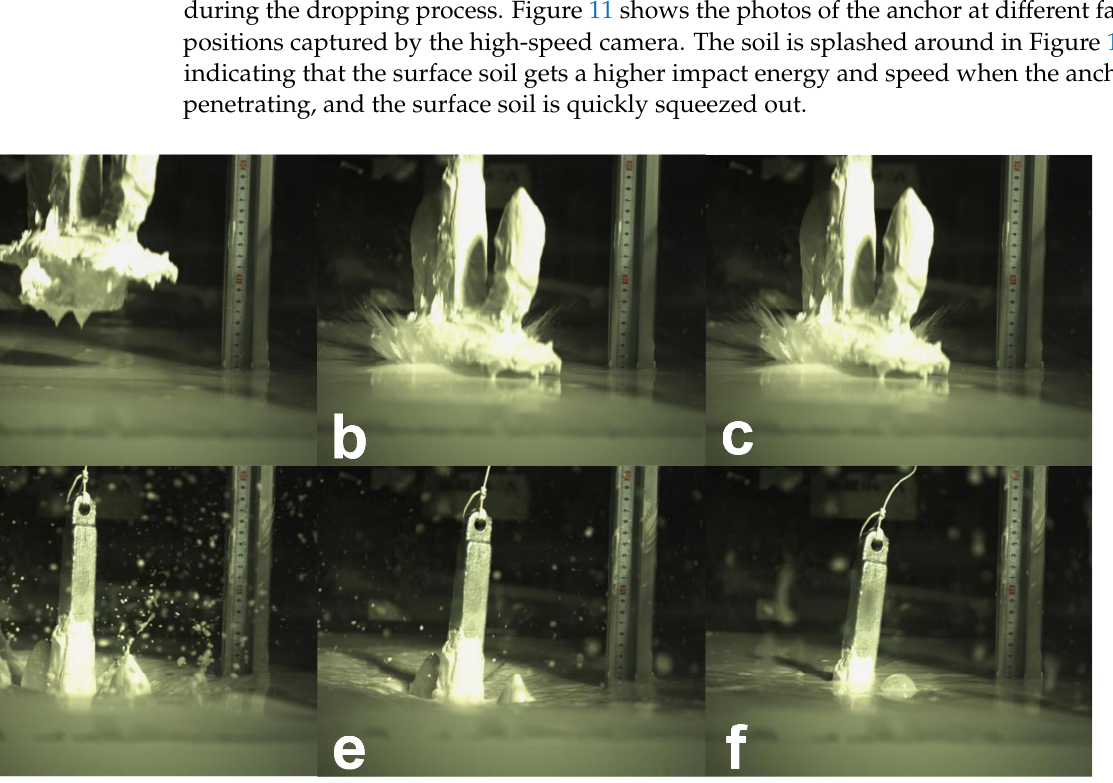
Figure 11. The different falling positions of the anchor in case F1-4. ( a ) The anchor is not touch the soil; ( b – e ) The anchor is penetrating the soil; ( f ) The anchor is in the maximum penetration depth. The curves of dropping velocity versus dropping height and penetration depth are plotted based on the information collected in the images, as shown in Figure 12. Figure 12b is a part of Figure 12a, which only shows the dropping velocity versus penetration depth in the soil. As shown in Figure 12b, A turning point exists when the anchor impacting the soil, which is caused by the following two reasons: (1) the impact energy is absorbed by the soil when the anchor hits the soil, therefore, the acceleration of the anchor will significantly decrease; and (2) the resistance of the soil increases due to the increase in contact area when the anchor touching the soil, which will also change the acceleration of the